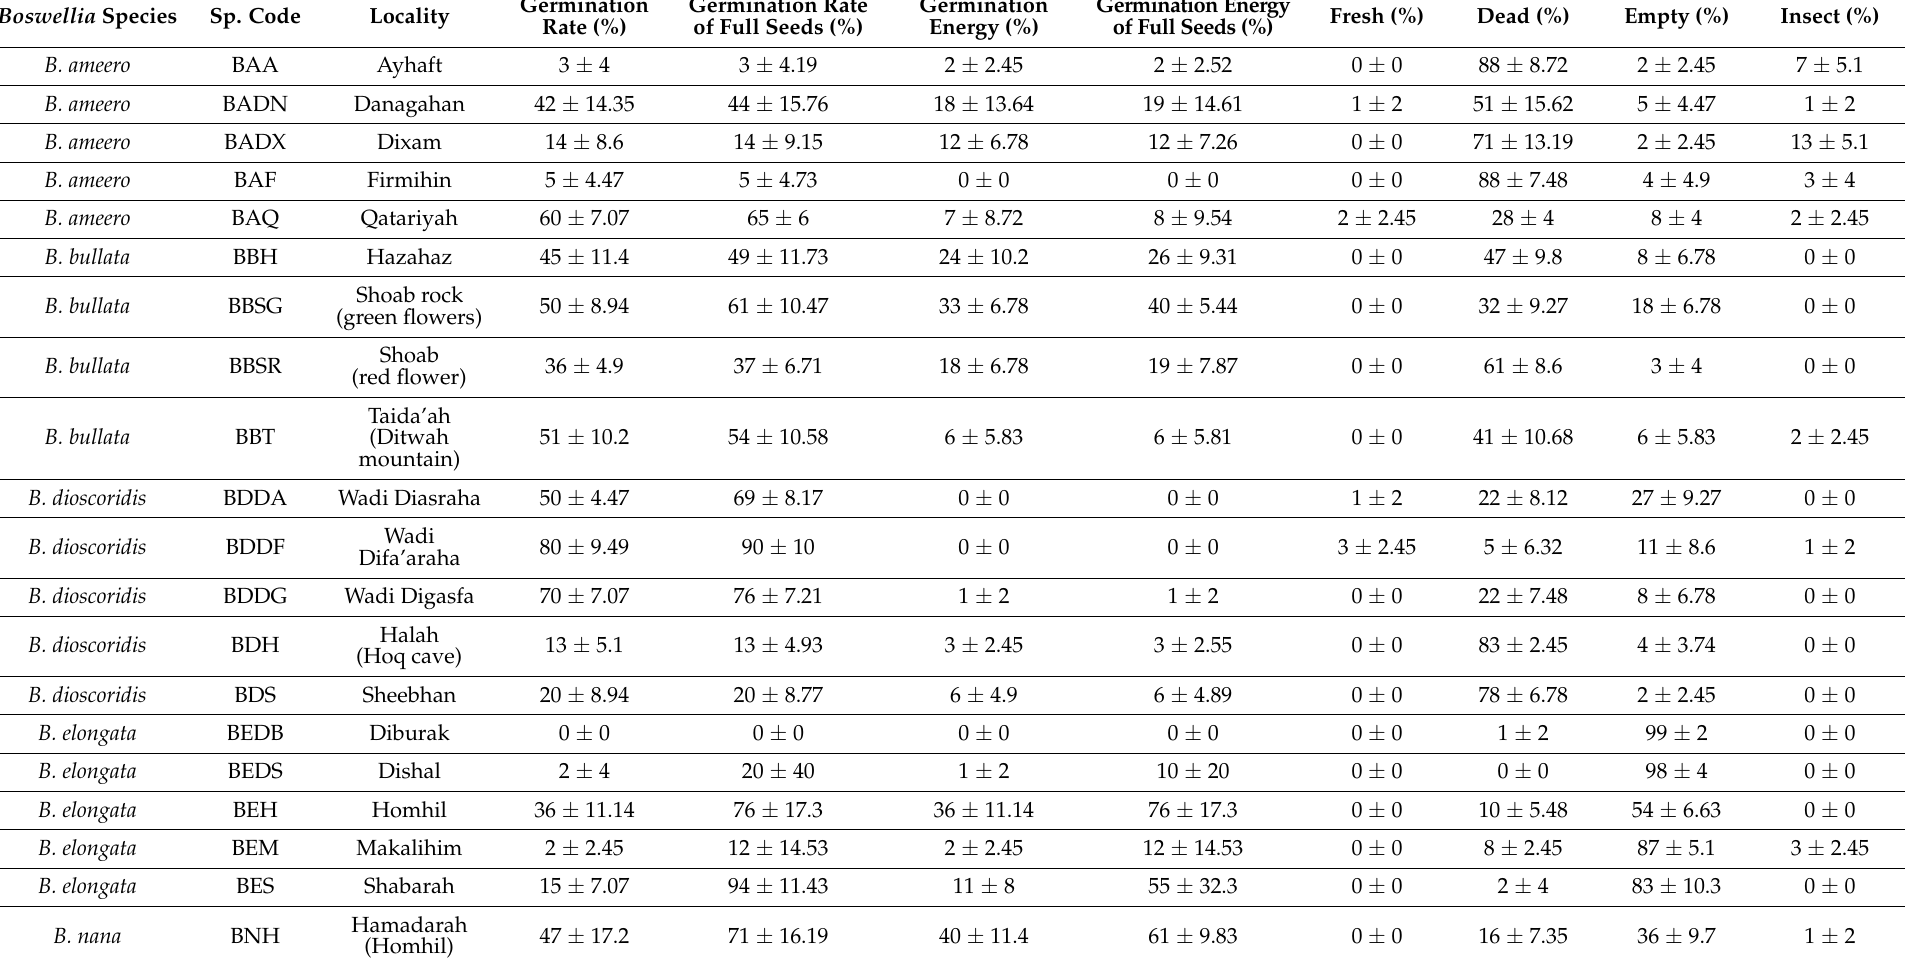
Table A2. Mean values from germination tests in 2021 ( ± standard